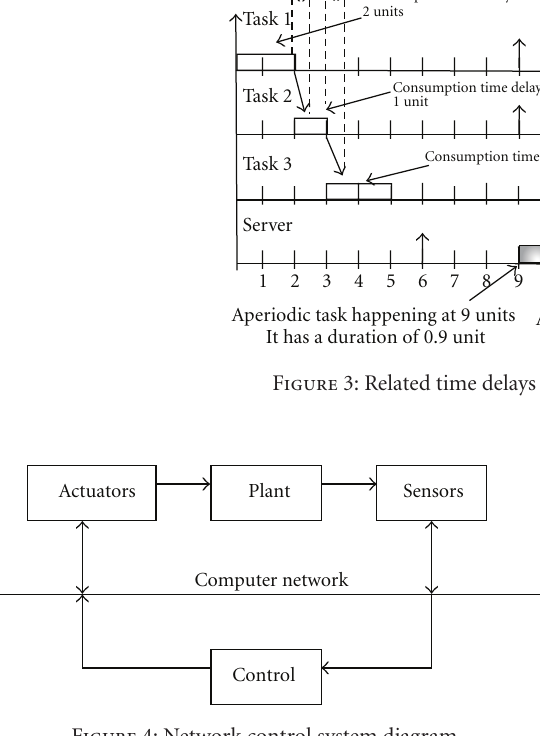
Figure 4: Network control system diagram.